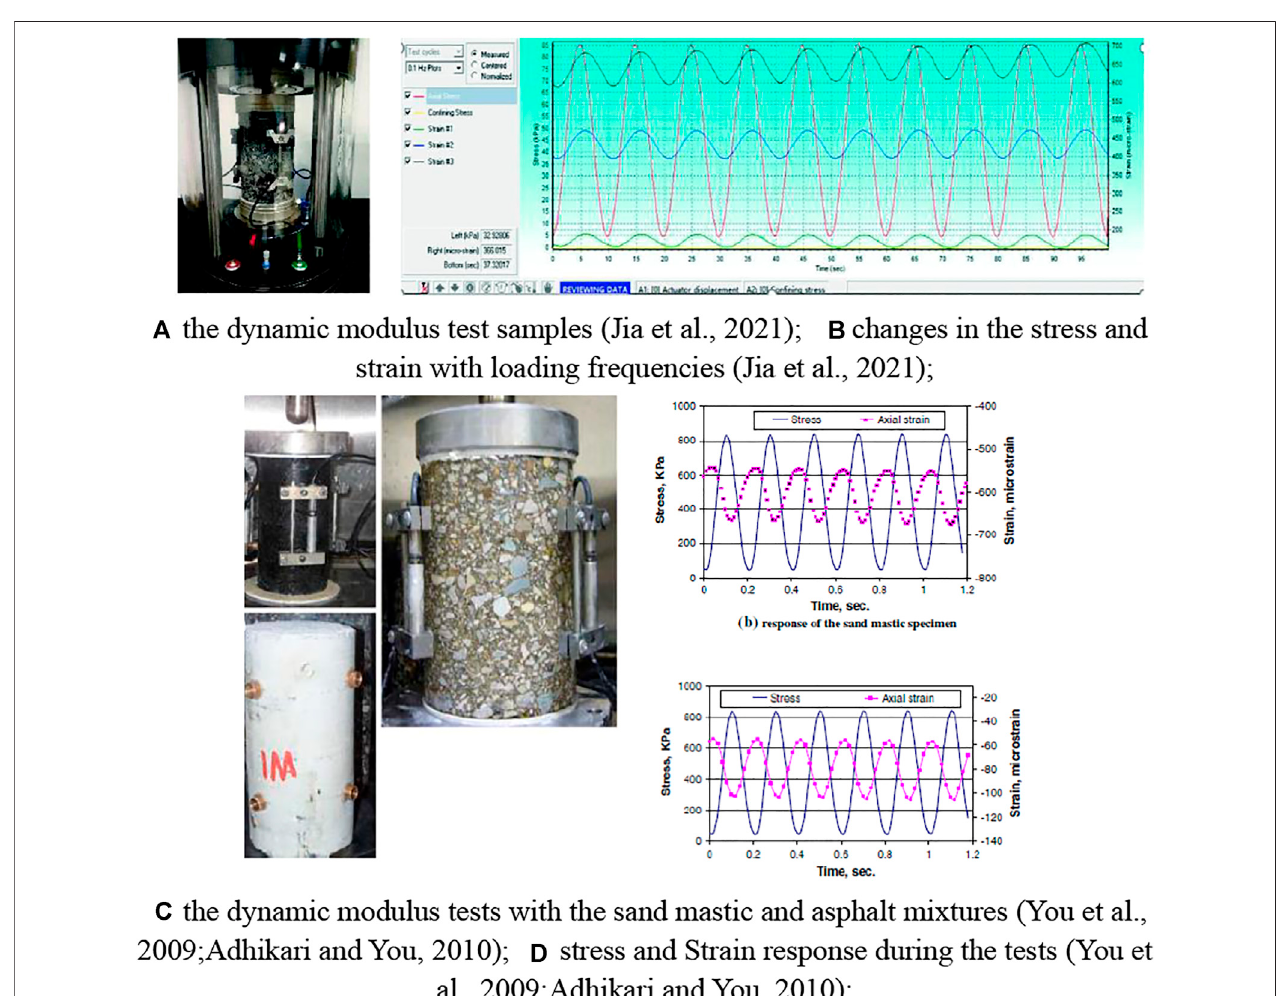
FIGURE 2 | Laboratory tests and processing for the dynamic modulus of the asphalt mixtures (Jia et al., 2021; You et al., 2009; Adhikari and You, 2010). (A) the dynamic modulus test samples (Jia et al., 2021); (B) changes in the stress and strain with loading frequencies (Jia et al., 2021); (C) the dynamic modulus tests with the sand mastic and asphalt mixtures (You et al., 2009; Adhikari and You, 2010); (D) stress and Strain response during the tests(You et al., 2009; Adhikari and You, 2010).